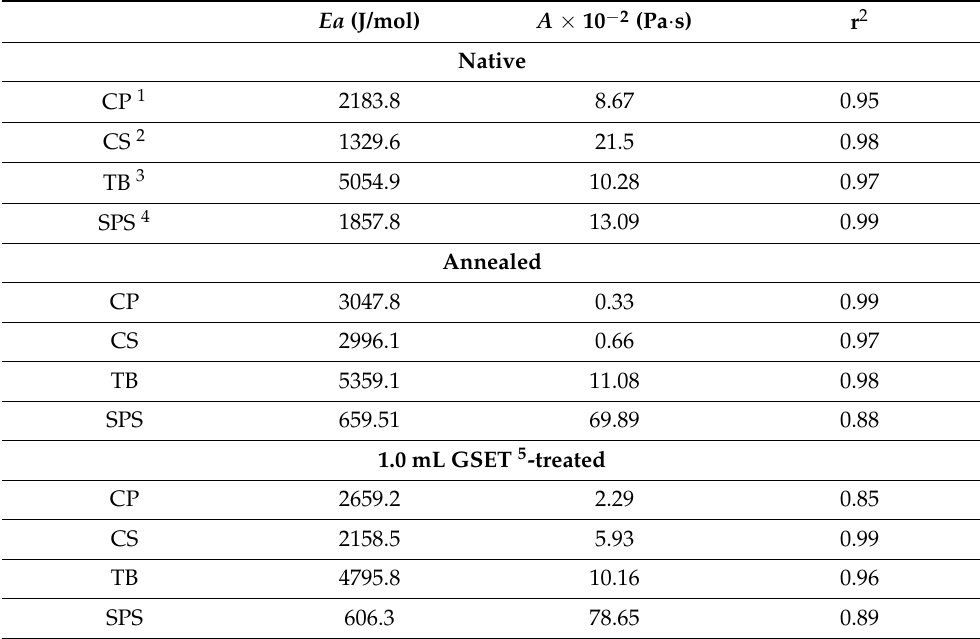
Table 4. Activation energies ( E a) of native, annealed and GSET-treated starch